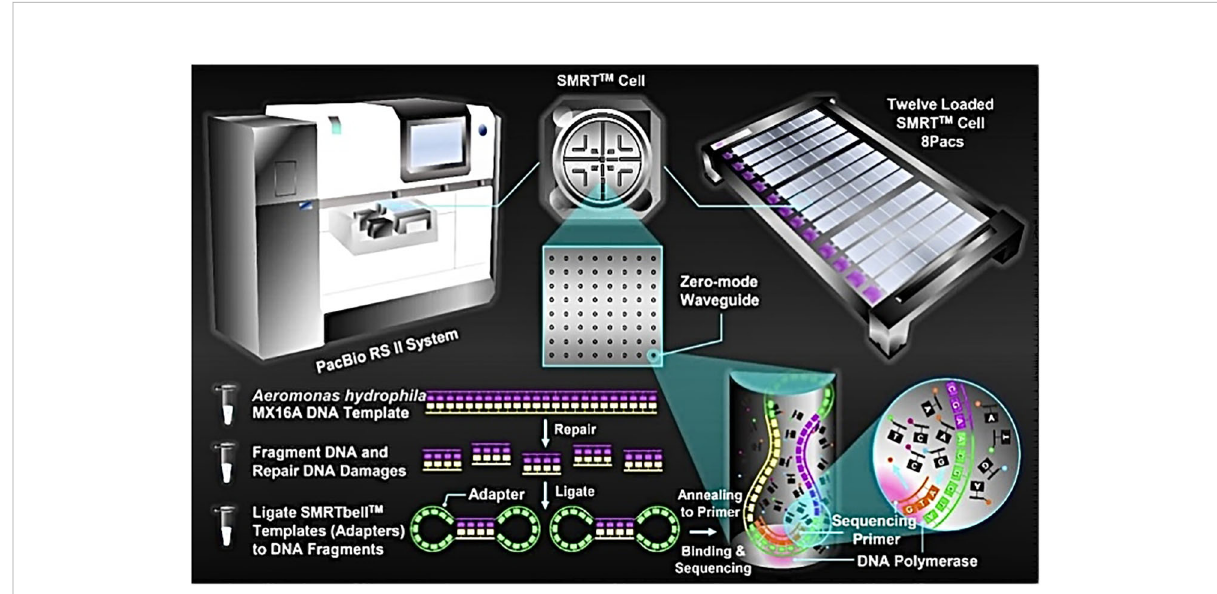
FIGURE 1 Schematic representation of PacBio ’ s DNA sequencing. A. hydrophila MX16A DNA sample was extracted by using a TIANamp Bacteria DNA Kit (Tiangen Biotech, Beijing, China) following the manufacturer ’ s